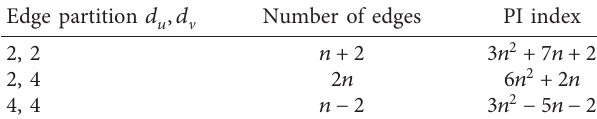
Table 14: Edge partition of ortho chain of n